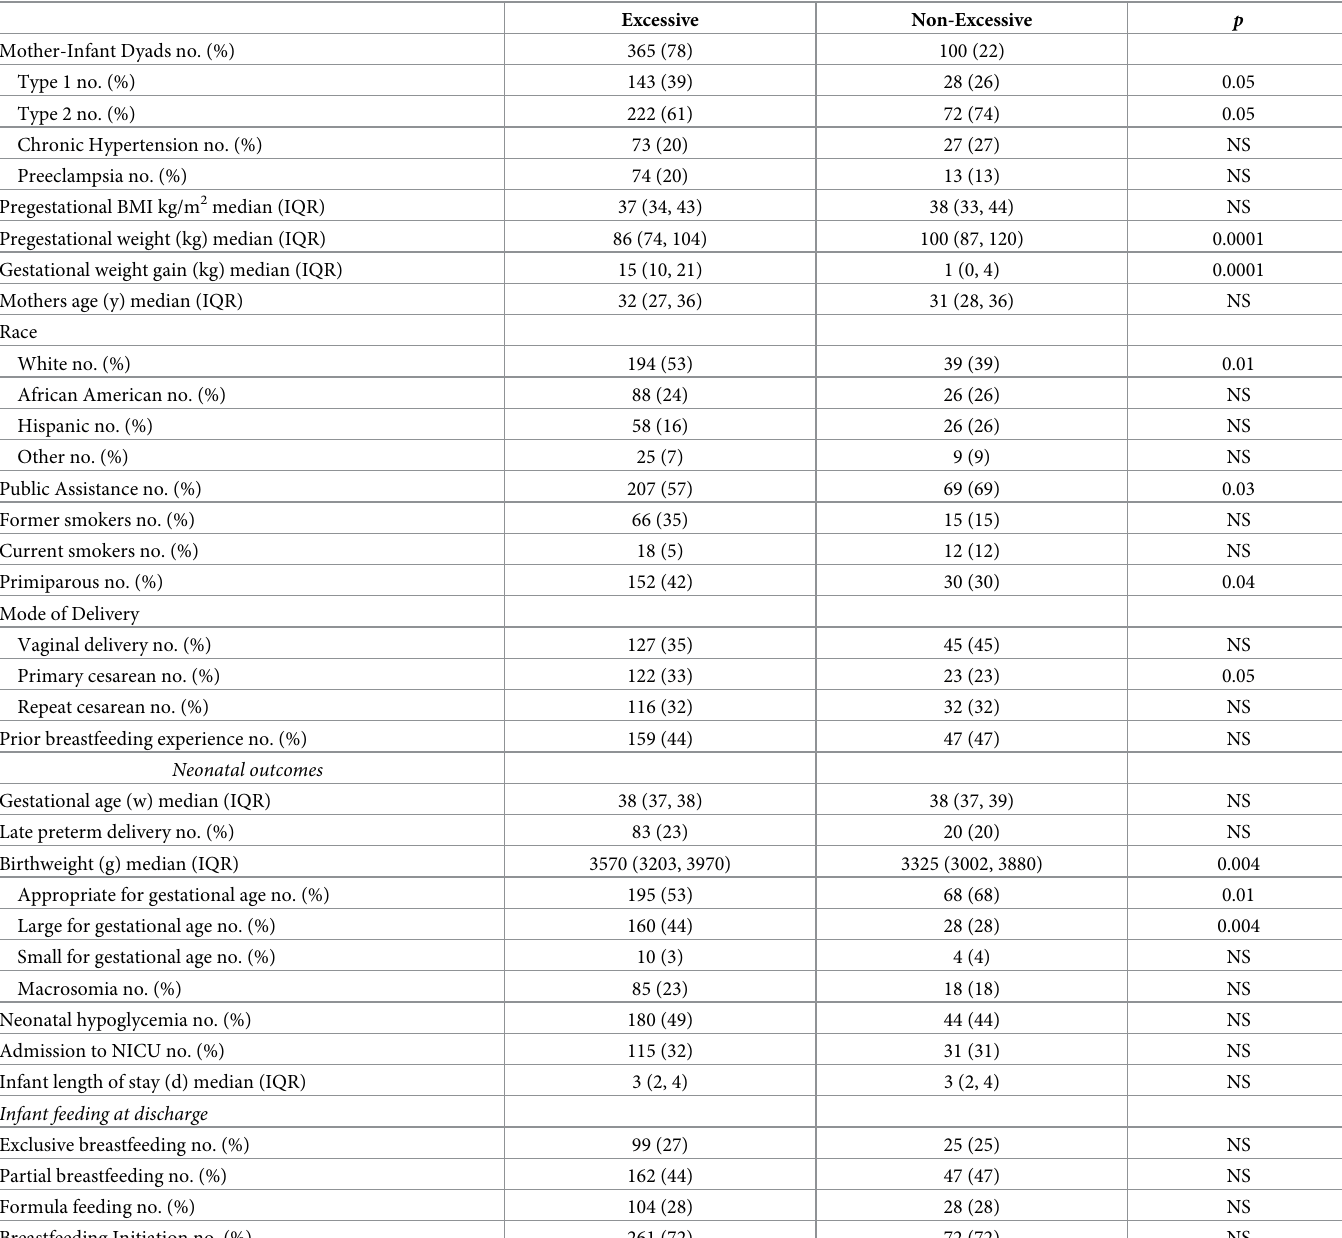
Table 3. Maternal and neonatal outcomes according to gestational weight